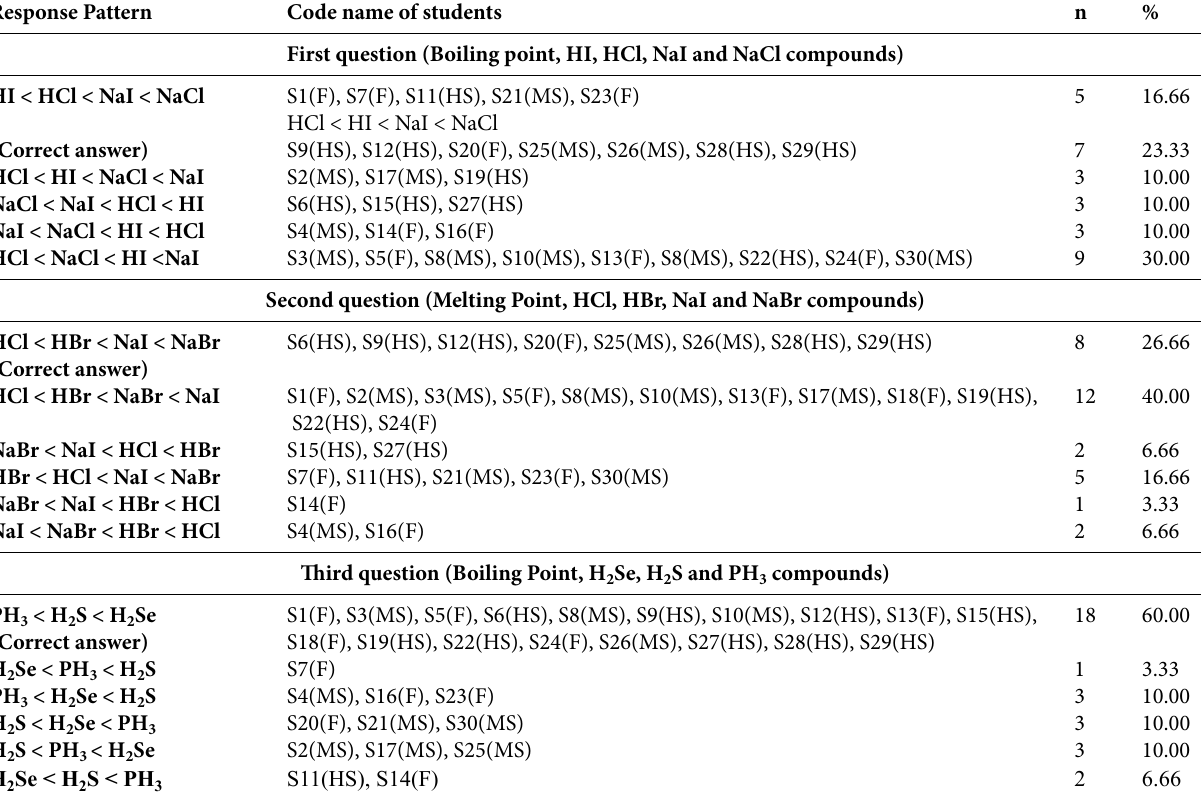
Table 1. Obtained Response